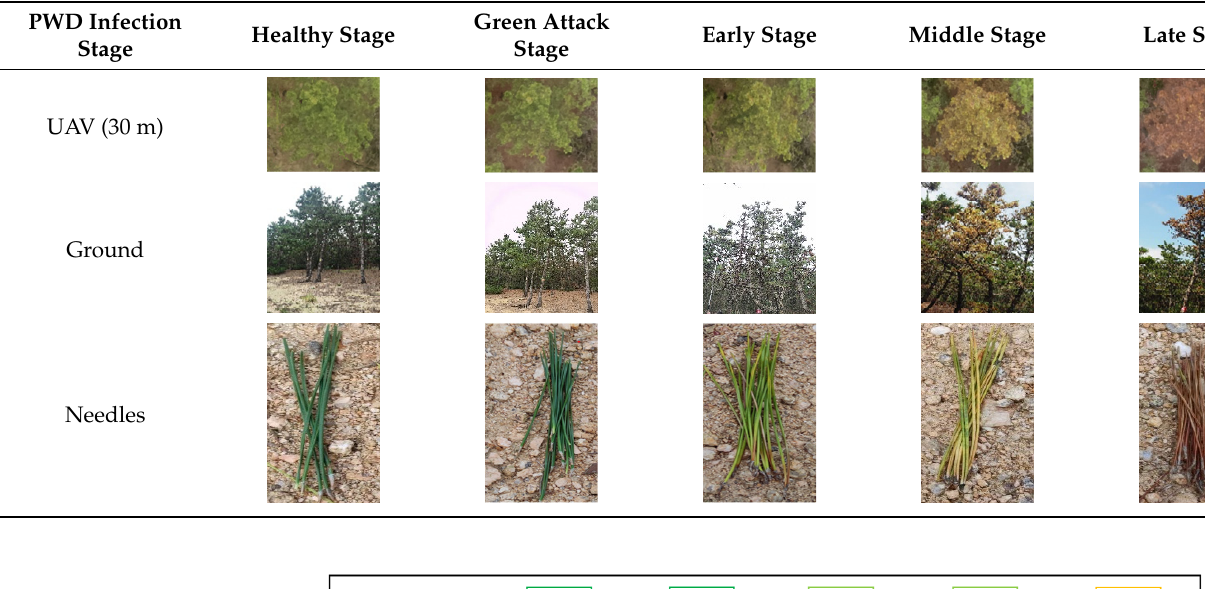
Table 1. Detailed apparent tree characteristics and classification criteria.